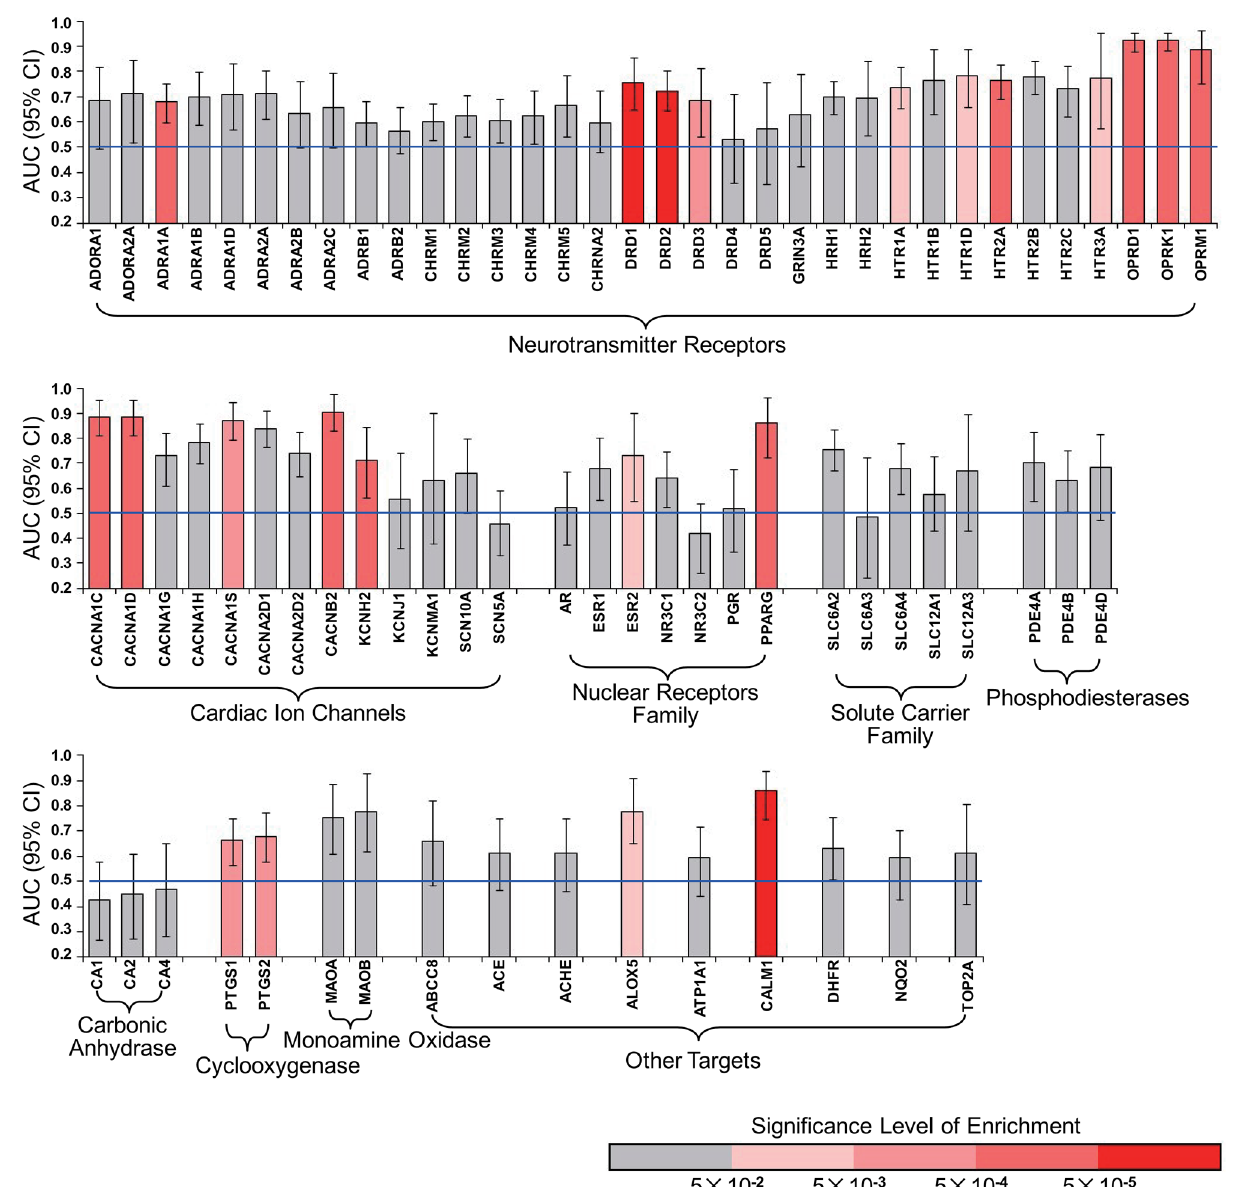
Figure 5. The performance of LOOCV suggests that at mRNA level, the genomic reactions of ligands binding differ dramatically from target to target. Here all the targets are displayed in several families, according to their functional origins. The height of each bar represents the AUC level (and 95% confidence interval). And the color of each bar indicates the significance level of benchmark ligands enrichment.